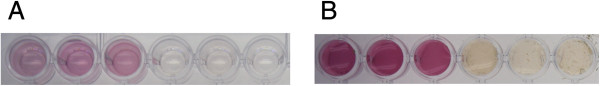
Test of ChitO-based assay on real substrates. (A) Shrimp shell treated with chitinase from Streptomyces griseus and (B) straw treated with cellulase from Aspergillus niger. Triplicates of the substrate treated with the hydrolase (left) are compared with triplicates of non-treated substrate (right). Images edited to improve contrast. ChitO, chito-oligosaccharide oxidase.